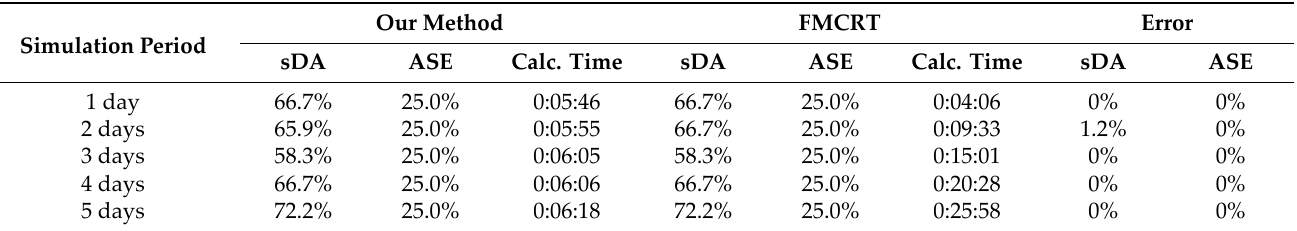
Table 6. Comparison of calculation time for different simulation periods (from 1 to 5 days). The first verification scene (Figure 3).